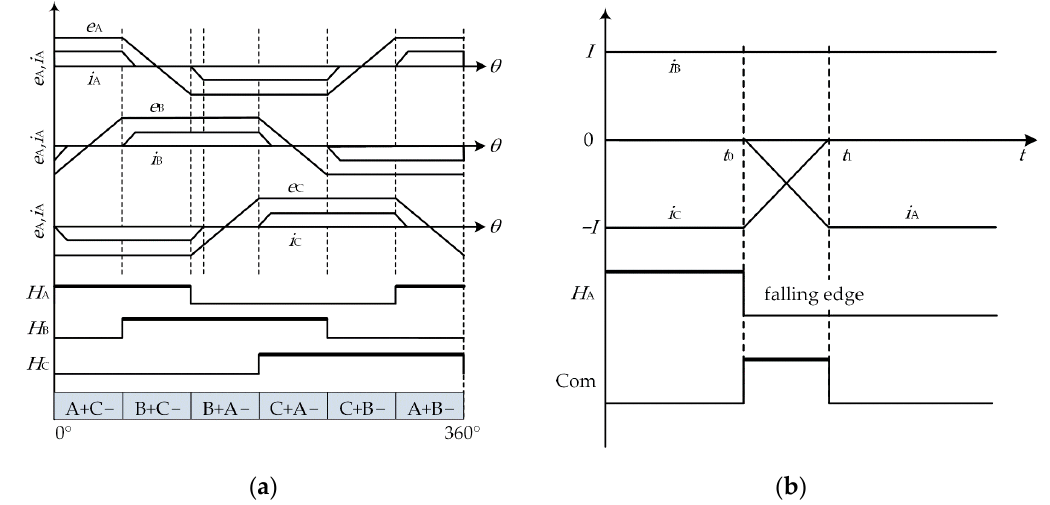
Figure 7. The corresponding relationship between back EMFs, phase current, and Hall signal: ( a ) The corresponding relationship in 360° electrical cycle; and ( b ) The commutation process of B + C − to B + A − .